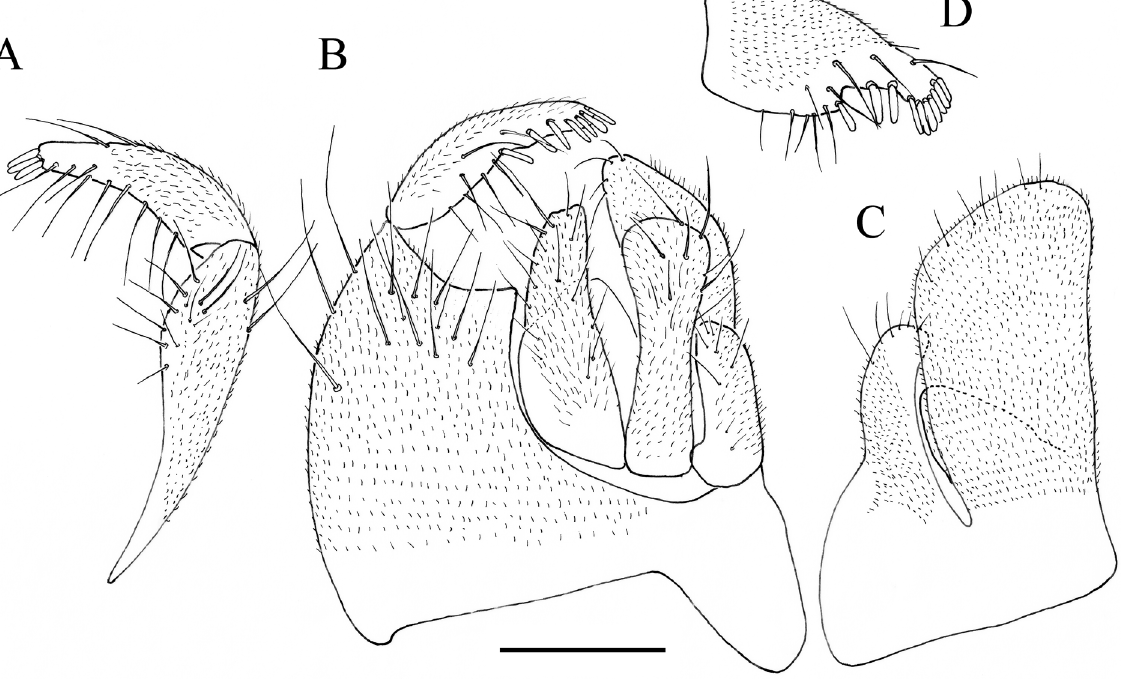
Fig. 5. Terminalia of the holotype of Tachydromia ebejeri Gonçalves, Grootaert & Andrade sp. nov., holotype (RBINS). A . Right surstylus and right epandrial lamella. B . Epandrium with cerci. C . Left epandrial lamella and left surstylus. D . Right surstylus. Scale bar: 0.1